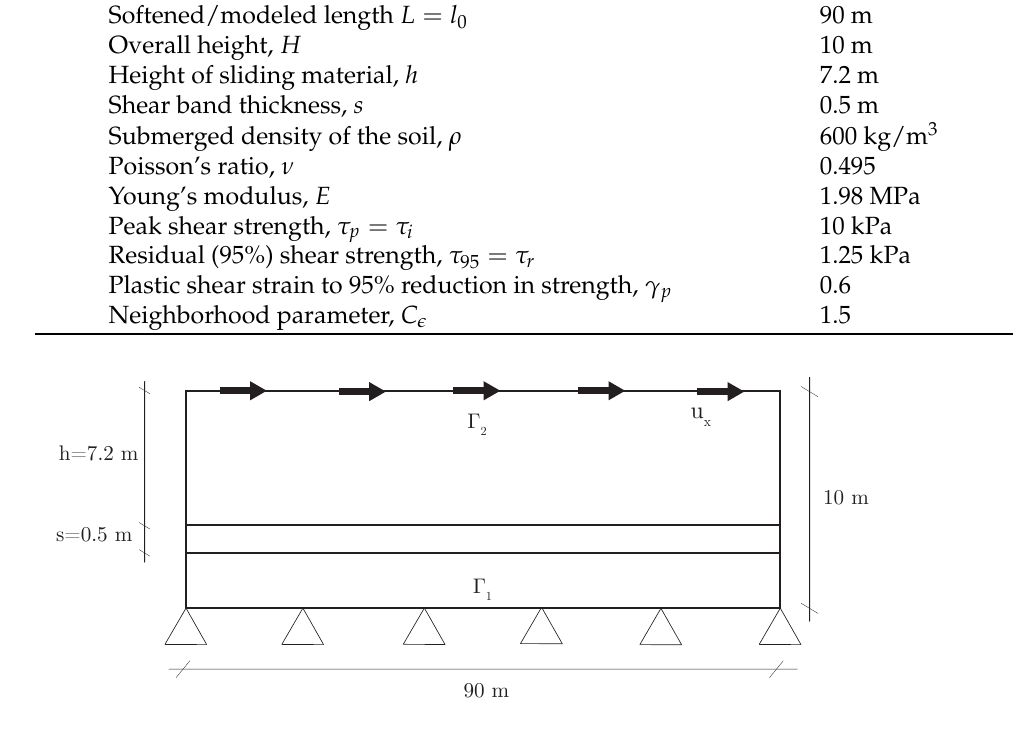
Figure 5. Geometry and loading conditions of the shear degradation